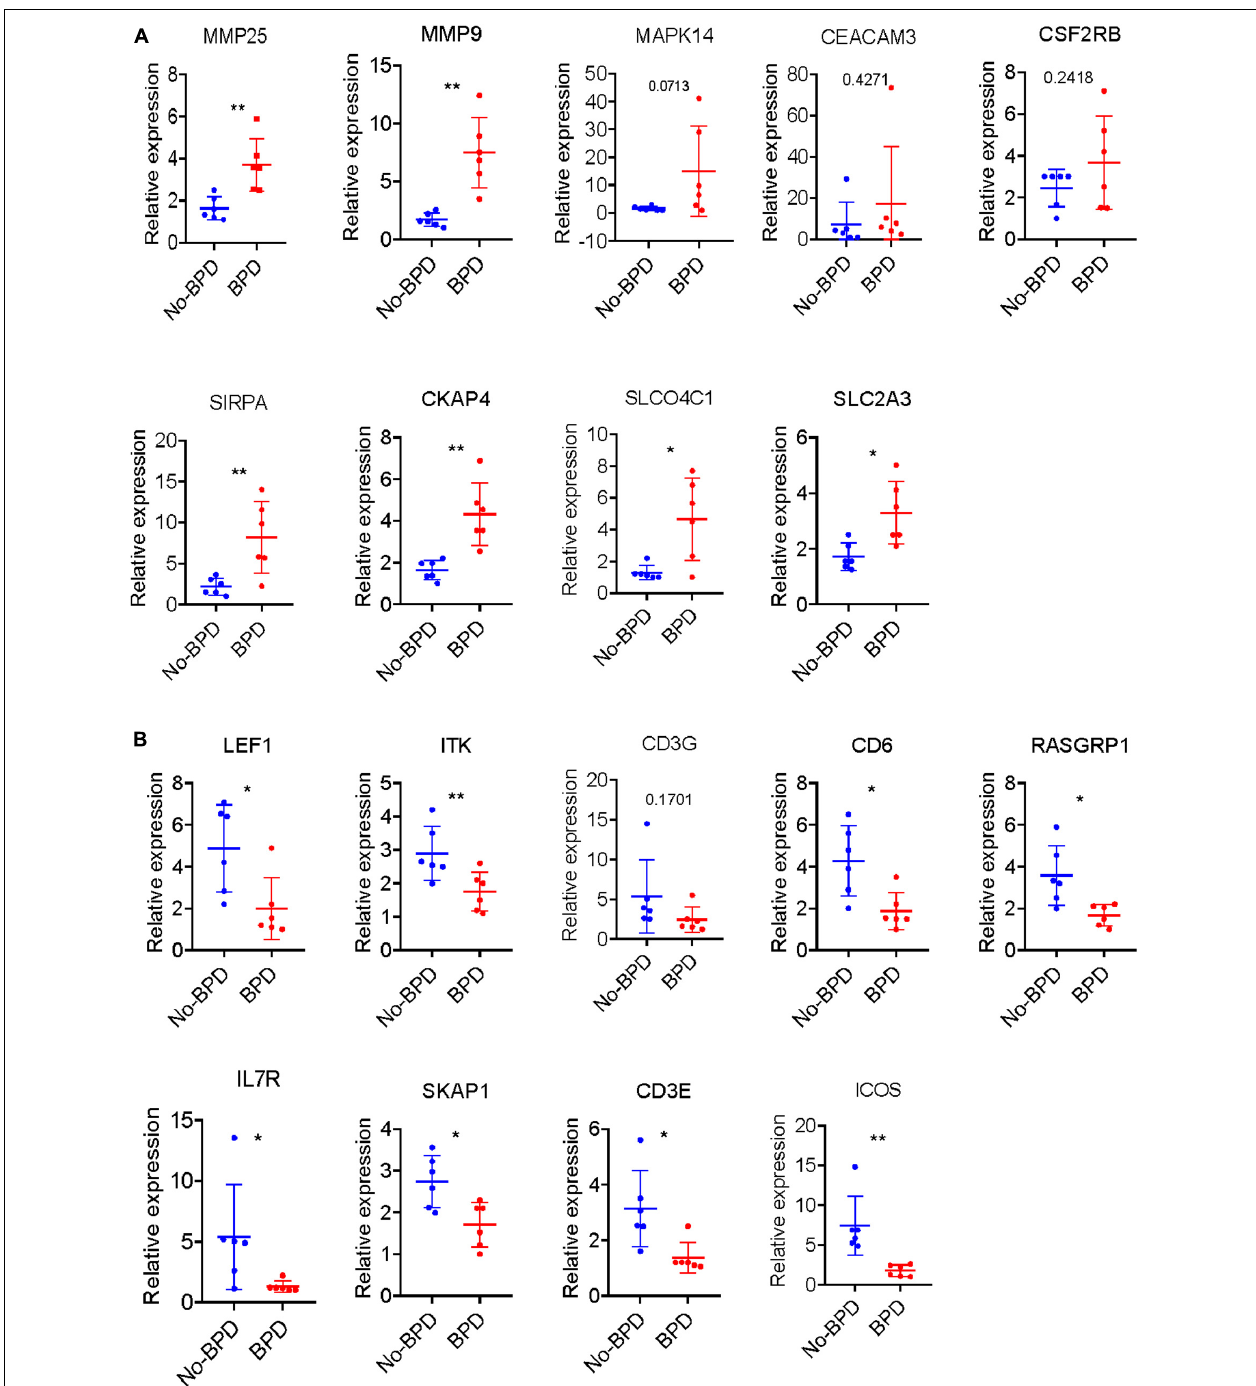
FIGURE 6 | Validation of hub genes by qRT-PCR. (A) Severity plot of the identified hub genes in the yellow module analyses by qRT-PCR. (B) Severity plot of the identified hub genes in the red module analyses by qRT-PCR. * P < 0.05 and ** P < 0.01.